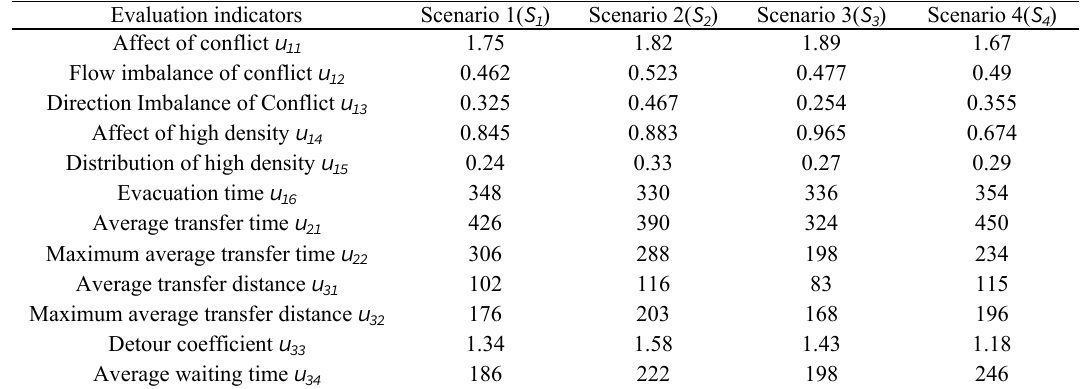
Table.3 Evaluation indicator values of different